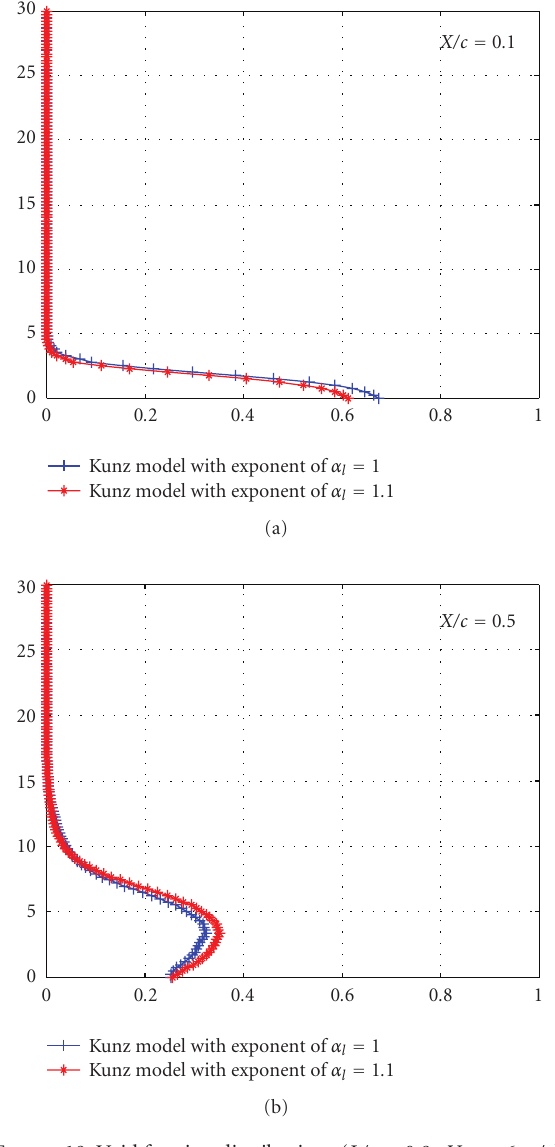
sources for Kunz and Reboud are nearly identical; this result suggests that the Kunz condensation model is